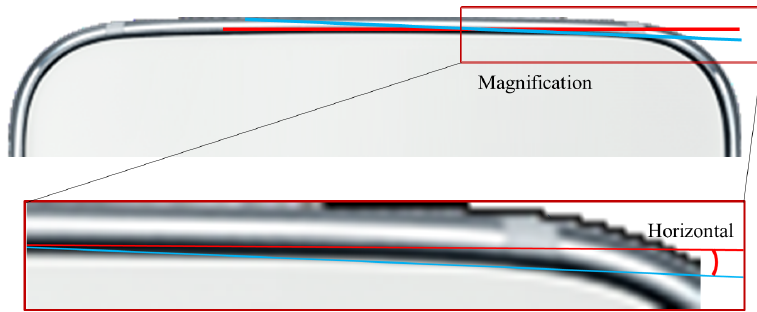
Figure 2. Example of a round design.